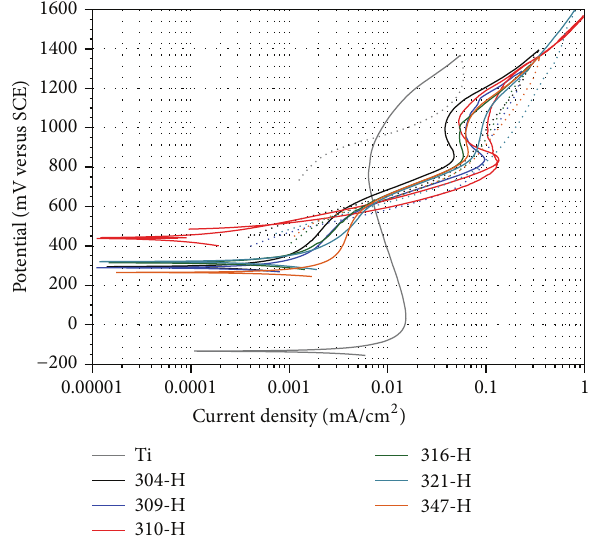
Figure 6: Cyclic polarization curves recorded for materials in mouthwash solution at 37 ∘ C, dE/dt = 0.167